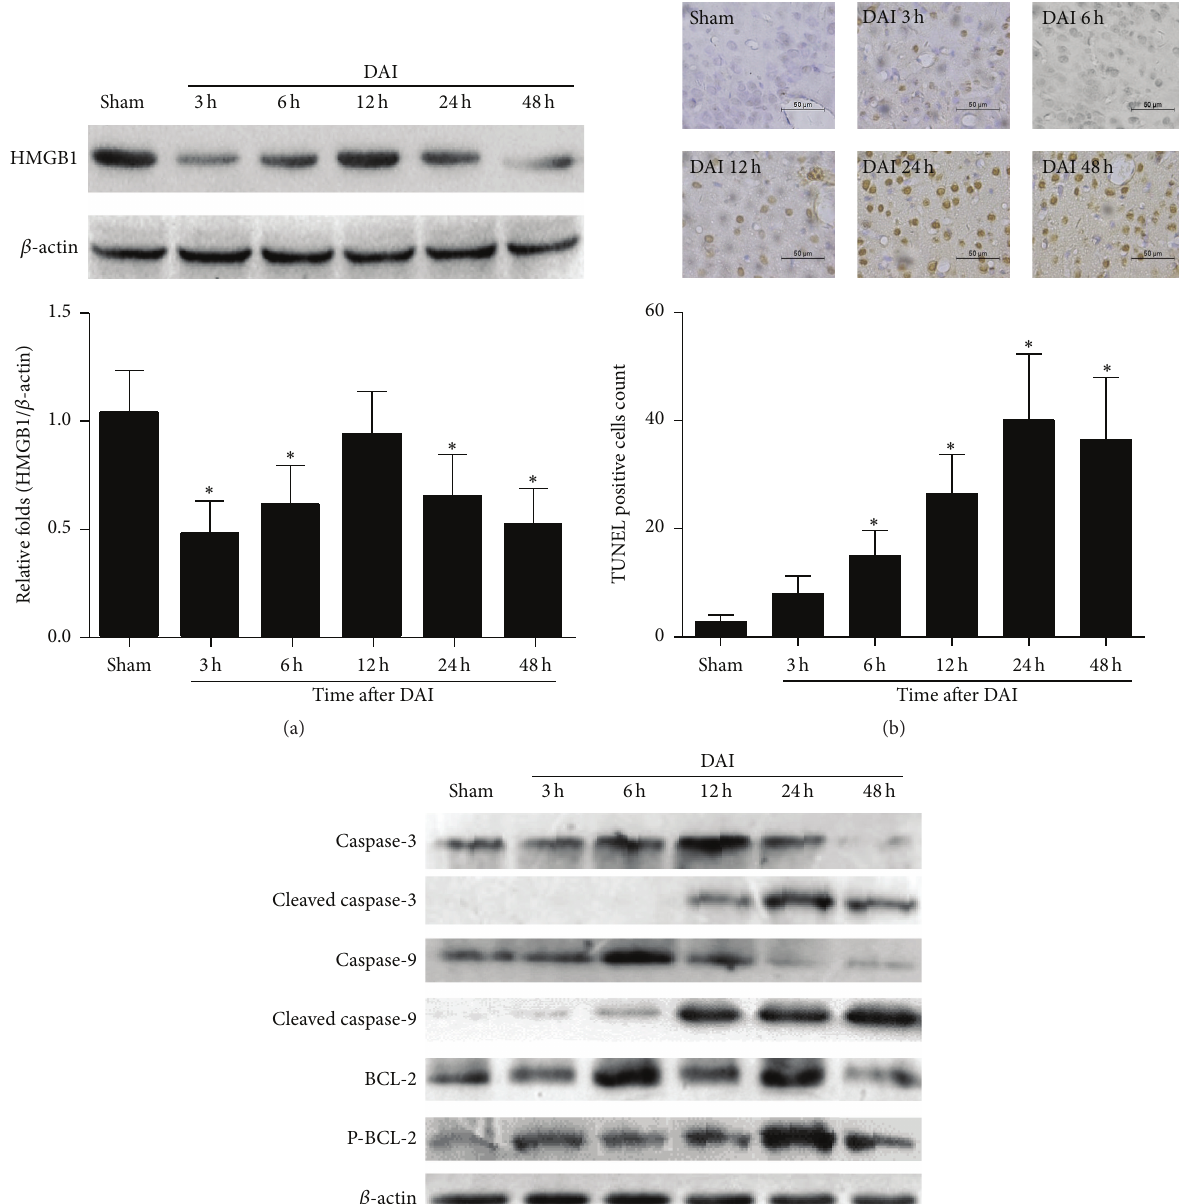
Figure 2: Dynamic expression of HMGB1 and neuronal apoptosis in rat brains after DAI. HMGB1 was significantly decreased in the first 48 h, with a transient increase at 12h after DAI (a). TUNEL staining showed a clear neuronal apoptosis from 6h to 48 h after DAI, with a time-dependent increase. The number of apoptotic cells was expressed as mean ± SD (b). The dynamic changes of the cleavage of caspases 3 and 9 and the phosphorylation of BCL-2 after DAI, detected by immunoblotting (c). ∗ 𝑝 < 0.05 compared with sham group.